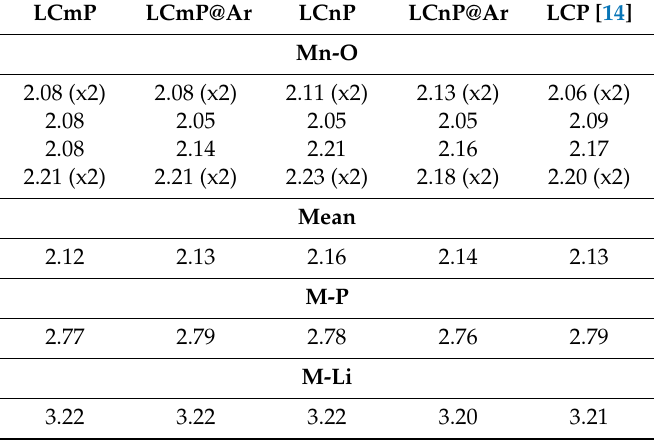
Table 3. Distances (Å, estimated mean uncertainty ± 0.01Å) and degeneracies (in parentheses) calculated from structural refinements of the XRD data.